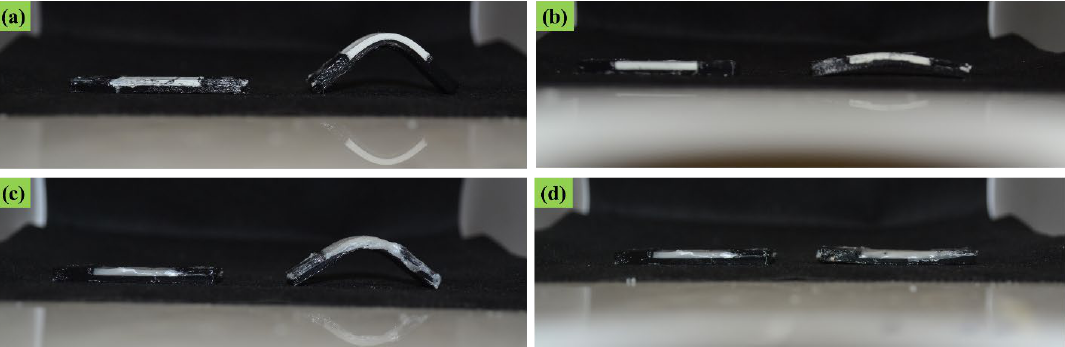
Figure 5. Shape memory properties in the first shape memory cycle: ( a ) fixity and ( b ) recovery for the ABS–TPU, and ( c ) fixity and ( d ) recovery for the PCL–TPU.